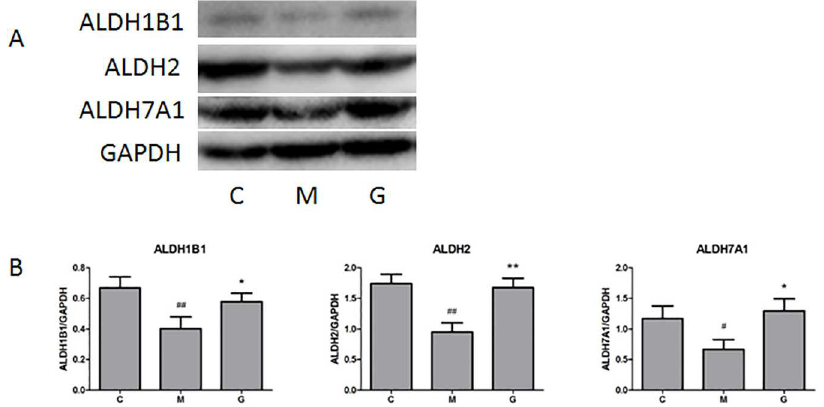
Fig 5. Effect of gypenoside on hepatic protein levels. Hepatic protein levels of ALDH1B1,ALDH2 and ALDH7A1were examinedin control, model and gypenoside groups by western blot. Hepatic GAPDH level was used as loadingcontrol. (C: control group; M: liver fibrosis model group; G: gypenoside group. Data are shown as mean ± SD. # P < 0.05, ## P < 0.01(vs. Control); * P < 0.05, ** P < 0.01(vs. Model).)